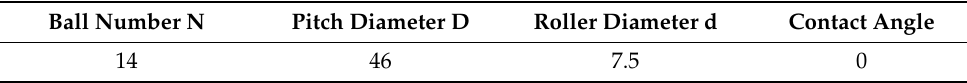
Figure 9. Failure diagram of the experimental bearing inner ring. Table 4. Bearing parameters.